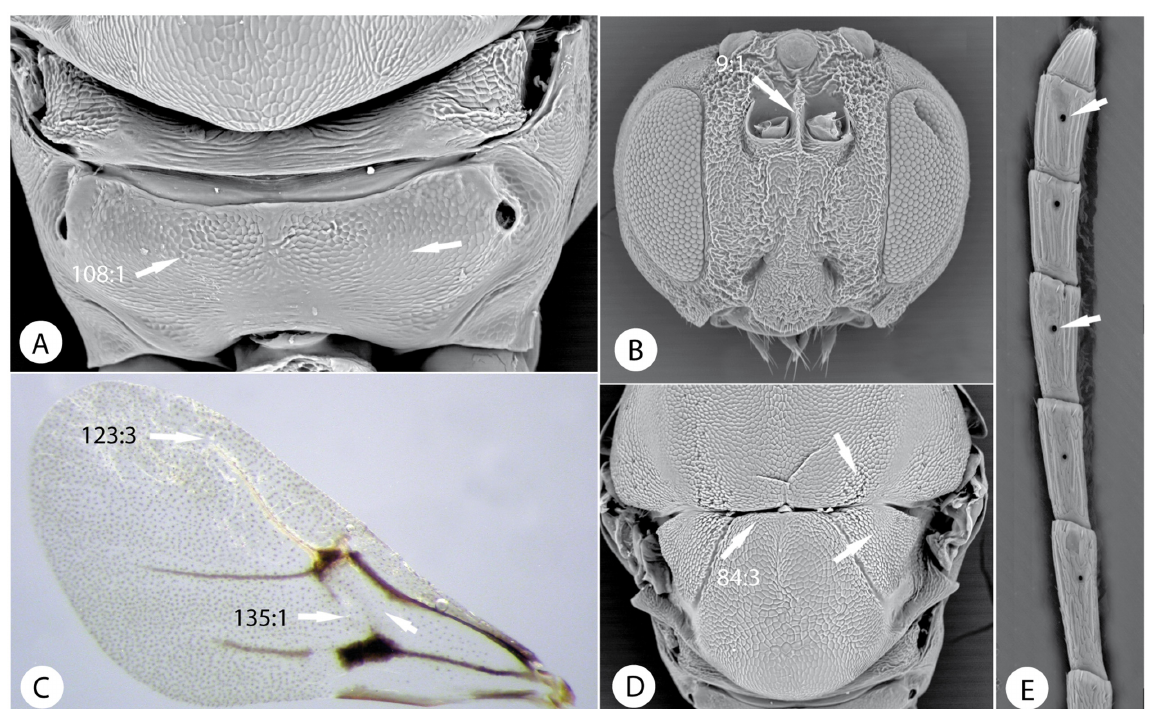
Fig 10. Morphological characters of Eschatocerini. Eschatocerus acaciae Mayr: A) propodeum. B) head, anterior view. C) fore wing. D) mesoscutellum in dorsal view. E) last flagellomeres of female antenna.